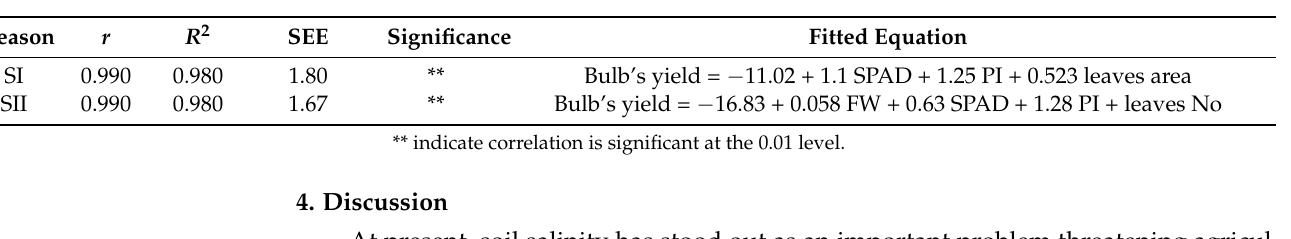
Table 9. Correlation coefficient ( r ), coefficient of determination ( R 2 ), and standard error of the estimates (SEE) for predicting onion yield for SI (2016/17) and SII (2017/18)